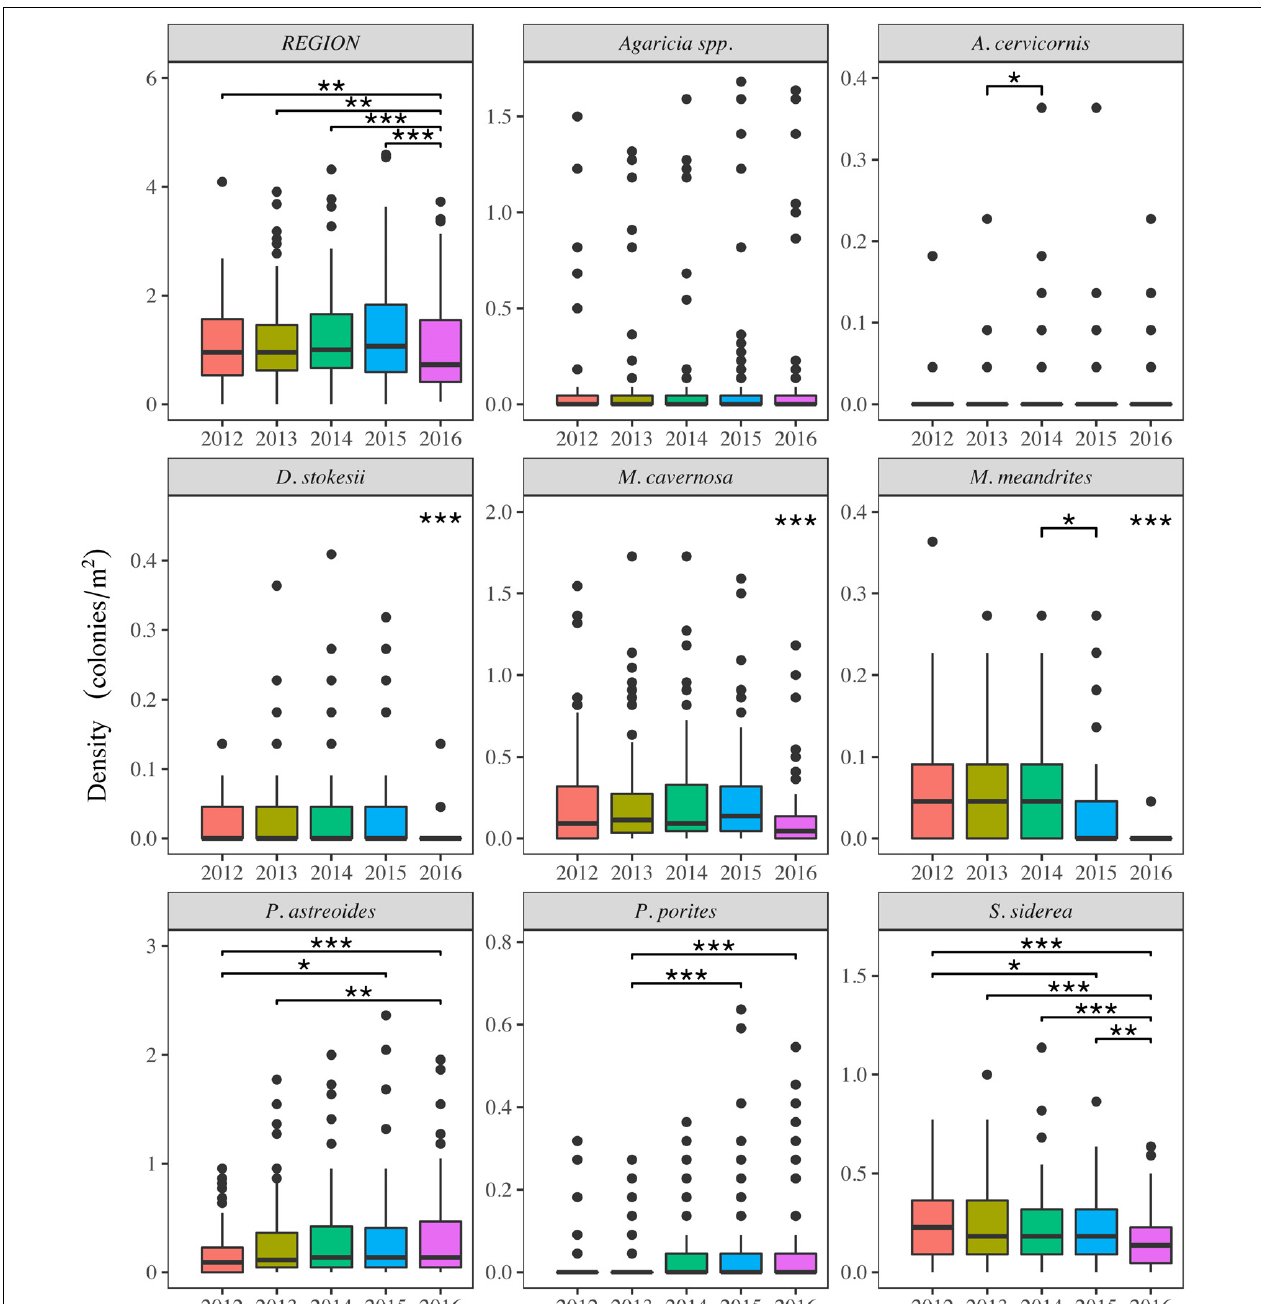
FIGURE 5 | Annual colony density for the region (top left) and coral species with significant changes from 2012 to 2016 ( p < 0.05). The middle bars of the boxplots represent the median values, the box length represents the interquartile range (IQR), the whiskers extend from the upper and lower IQR to the maximum and minimum values, and the dots indicate possible outliers. During this time period P. astreoides and P. porites had significant increases, Agaricia spp. had a significant overall change, but none of the pairwise comparisons were significant. All other species showed significant declines. Asterisks represent significant pairwise differences and the bars below the asterisks indicate the pairwise comparisons. ∗ p < 0.05; ∗∗ p < 0.01; ∗∗∗ p <